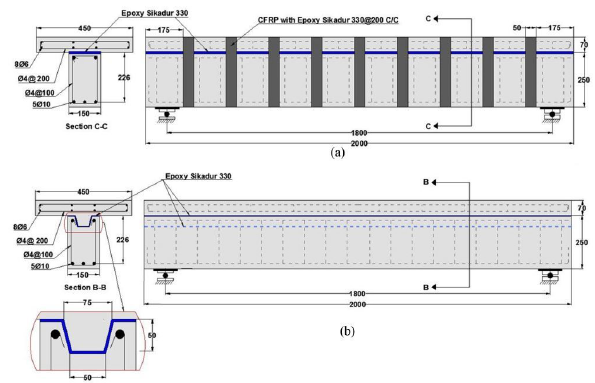
Figure 3: Details of the chemical connecting specimens (a) PB6;